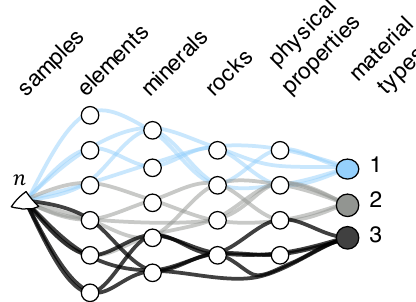
Figure 2. Conceptual diagram of material characterisation. Samples are composed of chemical elements and form into specific minerals, which form rocks or lithologies and have unique physical properties. The absence, presence, or combination of these attributes helps to distinguish material types. Colours are used for discrimination of possible pathways to characterise material